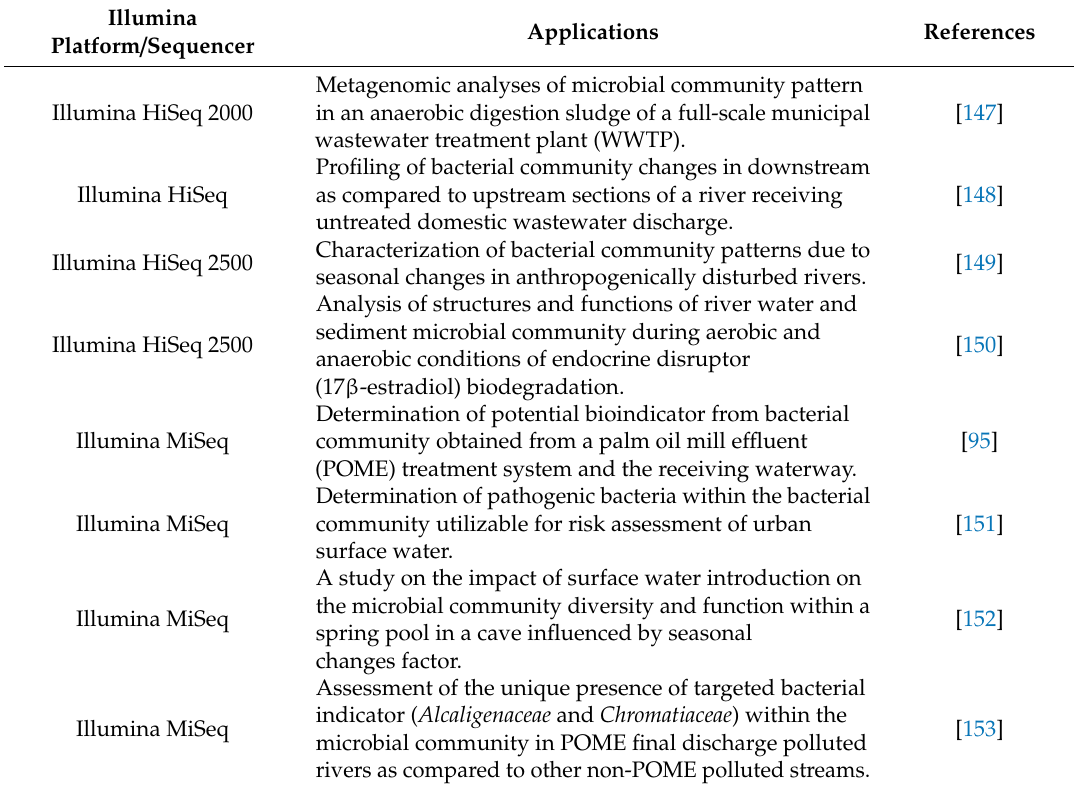
Table 4. Metagenomics application of Illumina platform for microbial community assessment in wastewaters and polluted